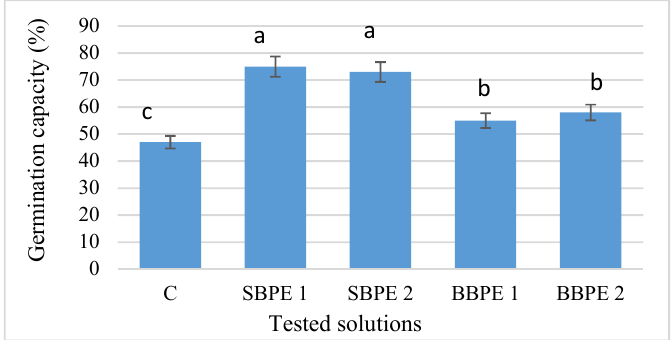
Figure 1. Influence of bark extracts on Melissa officinalis L. seed germination capacity. Different letters indicate significant differences ( p ≤ 0.05). Error bars represent the standard deviations of means. C—control. SBPE 1—spruce bark polyphenolic extract at a concentration of 0.25 g bark/100 mL water. SBPE 2—spruce bark polyphenolic extract at a concentration of 0.5 g bark/100 mL water. BBPE 1—beech bark polyphenolic extract at a concentration of 0.25 g bark/100 mL water. BBPE 2—beech bark polyphenolic extract at a concentration of 0.5 g bark/100 mL water.